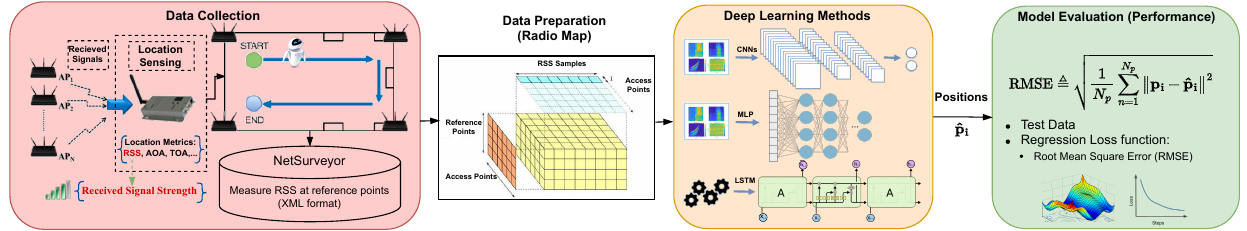
Figure 7. Steps of building and evaluation of the proposed deep network process for RSS-based WLAN